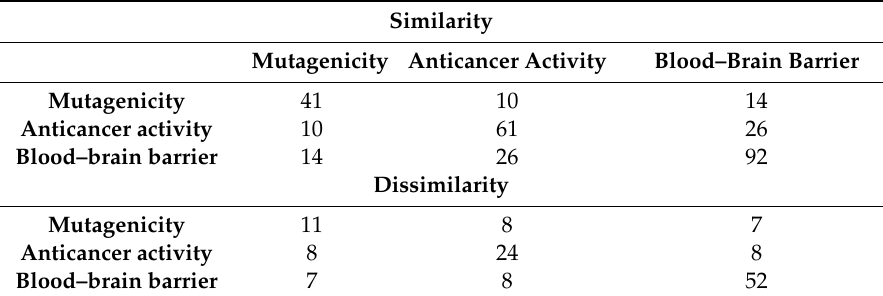
Table 7. The matrix of similarity for examining endpoints.